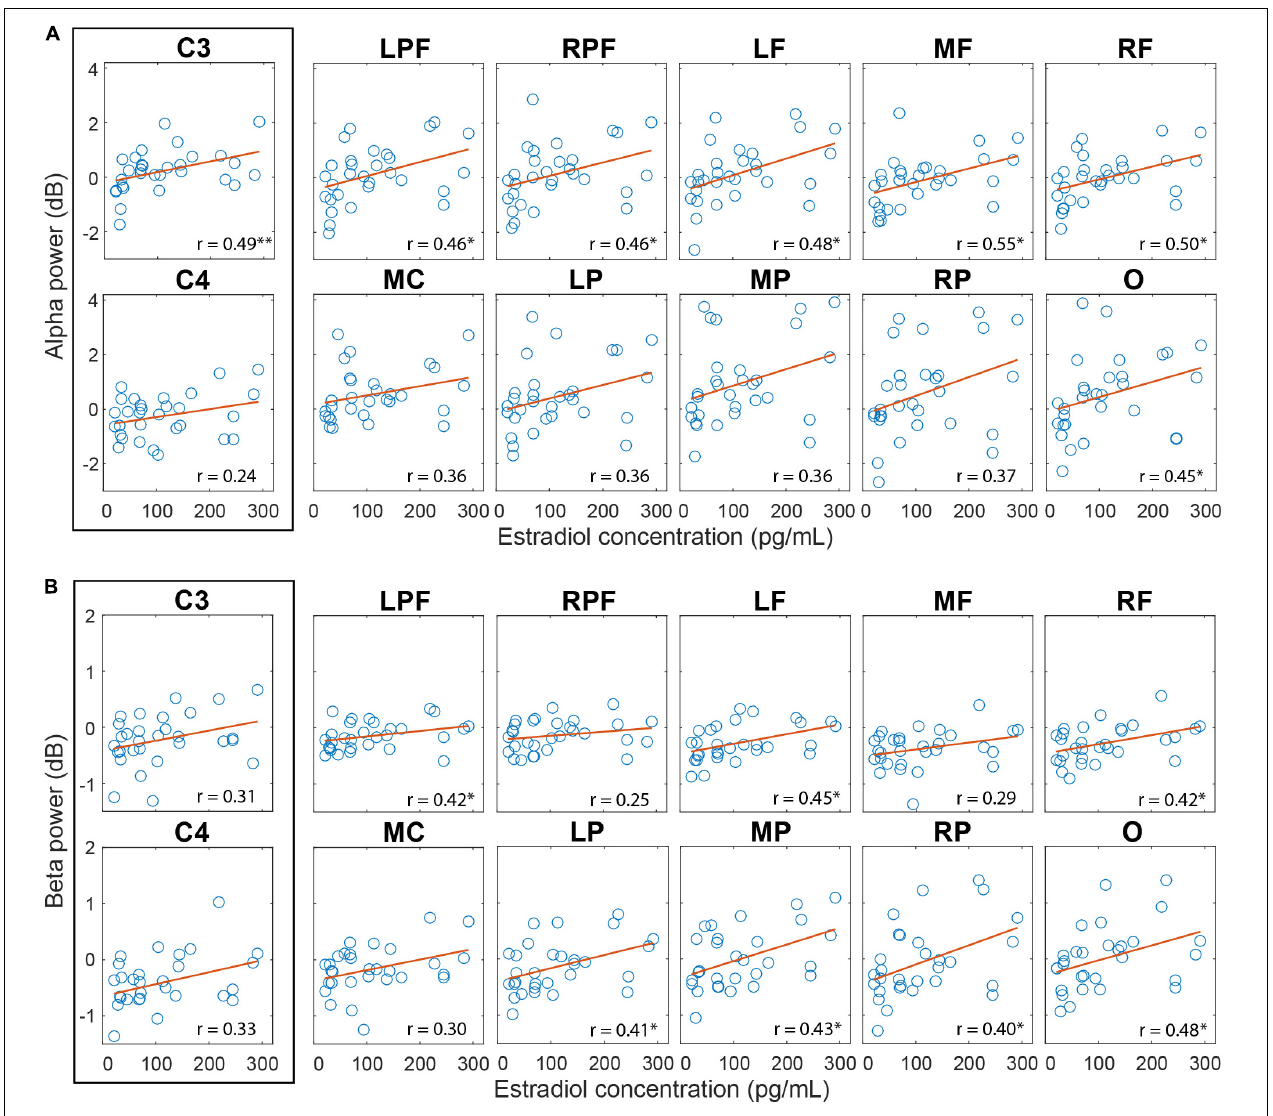
FIGURE 6 | Correlation between cortical activity during AO and estradiol levels in the follicular phase. (A) Correlation between the alpha amplitude and the estradiol level. (B) Correlation between beta amplitude and estradiol level. Regions with significant correlations have an asterisk. P -value: < 0.001 ( ∗∗ ), < 0.05 ( ∗ ); FDR